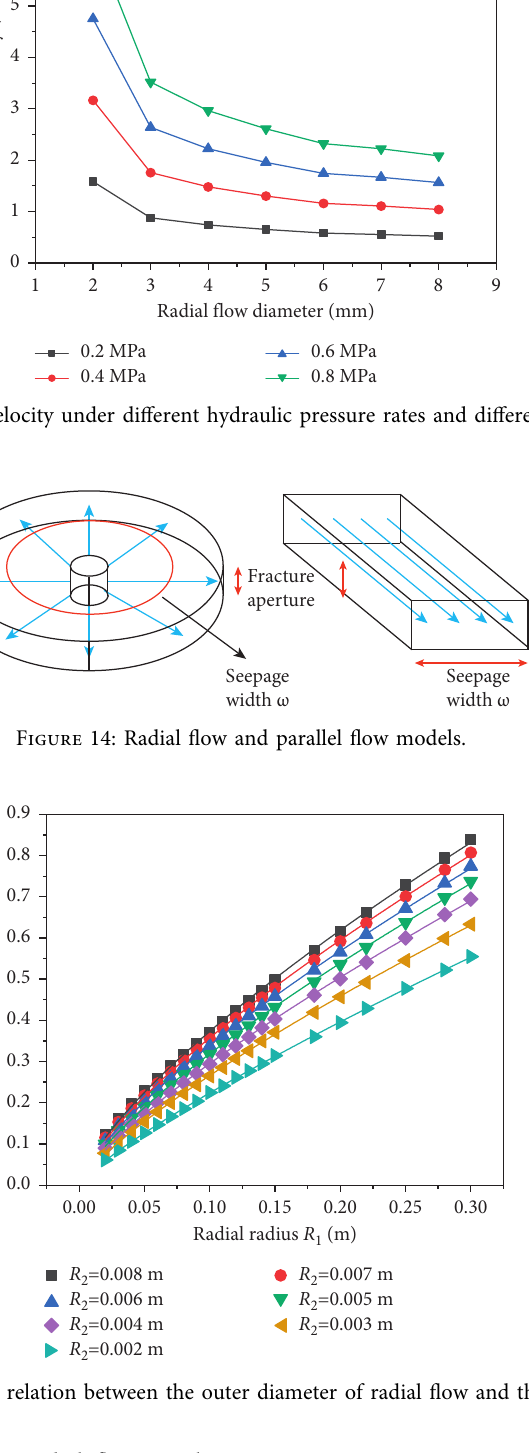
Figure 15: The fitting relation between the outer diameter of radial flow and the seepage